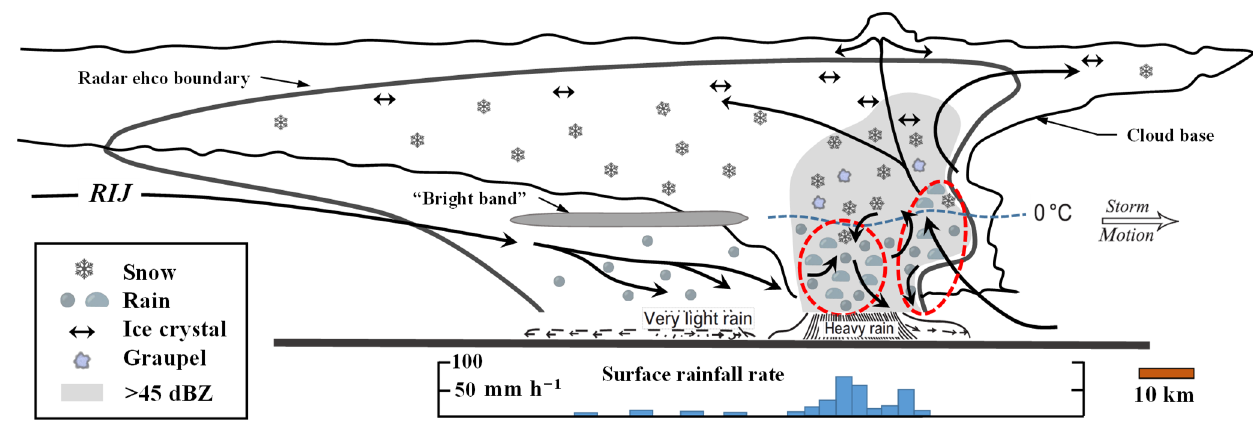
Figure 12. Conceptual model of the kinematic, microphysical and radar echo structures of the BSL observed on 10 May 2021 in eastern China. The dotted red ovals indicate the approximate locations of the two high- Z DR bands.